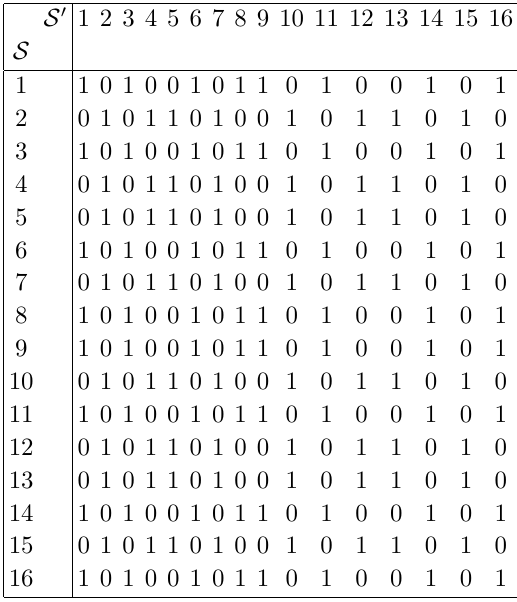
Table 23 . Gadget values for P